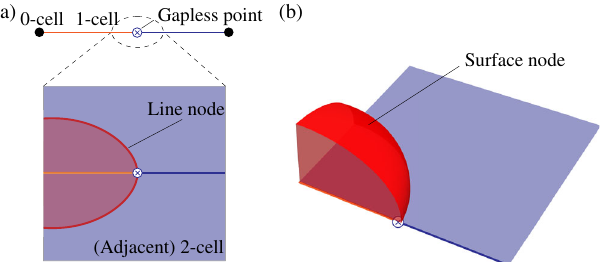
FIG. 11. Illustration of nodes near a gapless point at a 1-cell. (a) Two divisions of the 1-cell and nodal lines in adjacent 2-cells. Here, the red shaded region and others have different values of the topological invariants, whose boundary results in a nodal line. (b) Surface node. When there are compatibility conditions between the 2-cell and adjacent 3-cells, the regions in (a) are extended to 3-cells, and the boundary surface is the surface